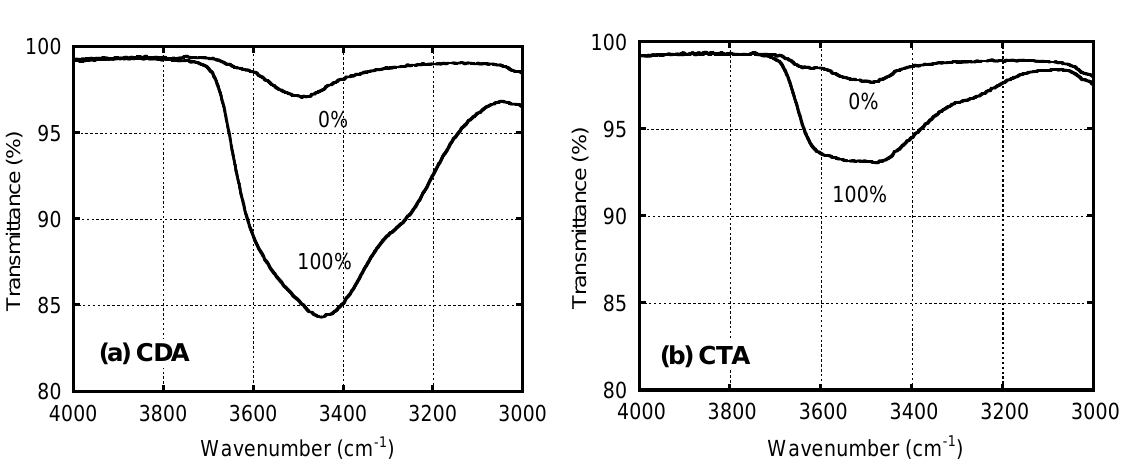
Figure 8. ATR-FTIR spectra (3,000–4,000 cm −1 ) of (a) CDA and (b) CTA before (0%) and after (100%)